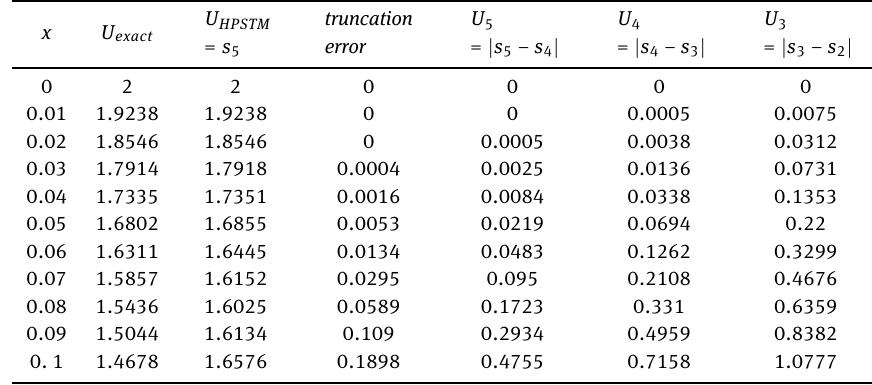
Table 1: Numerical solution when λ = 2